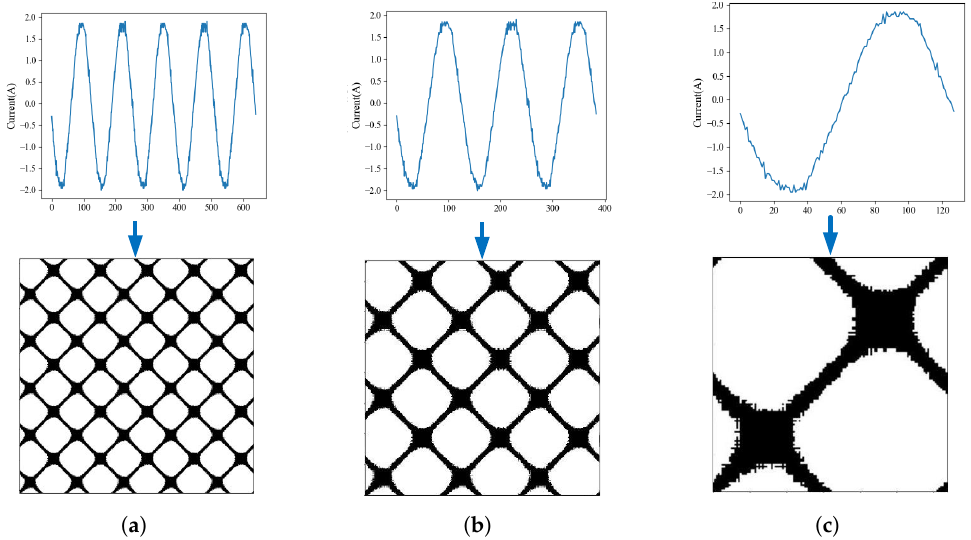
Figure 4. Current sequence with different time length and corresponding RP. ( a ) Five cycles. ( b ) Three cycles. ( c ) Single